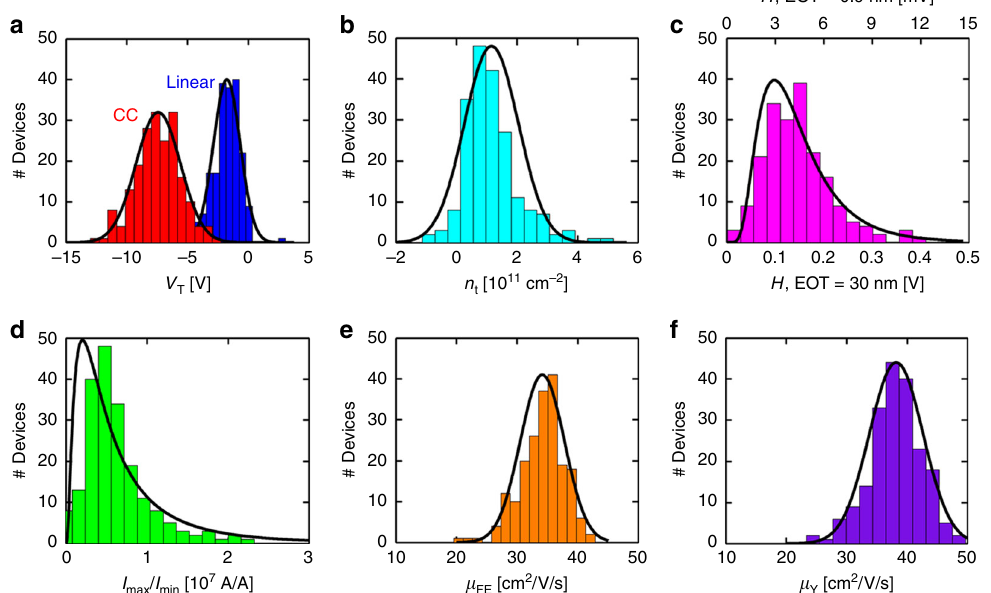
Fig. 1 Example of an outstanding variability analysis of multiple parameters of hundreds of MoS 2 FETs, which furthermore are grown using a scalable method (i.e. CVD). a shows the value of V TH for both the linear extrapolation (blue) and constant-current (red) methods, b shows the value of n t , c the value of the hysteresis, d the I MAX / I MIN ratio, and e , f the values of the mobility extracted from the fi eld-effect approach and the Y -function approach (respectively). Reproduced with permission from ref. 9 Copyright American Chemical Society,